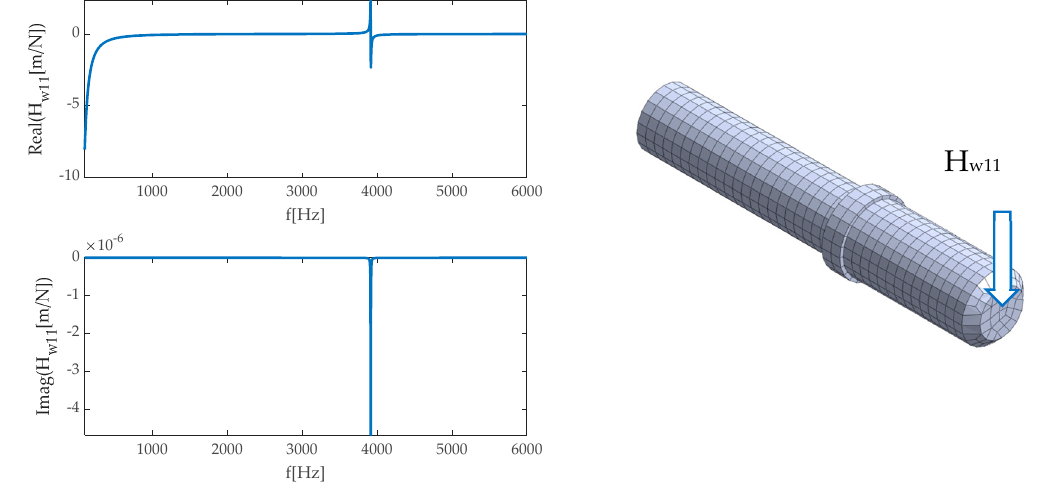
Figure 12. An example of FRF for the workpiece.